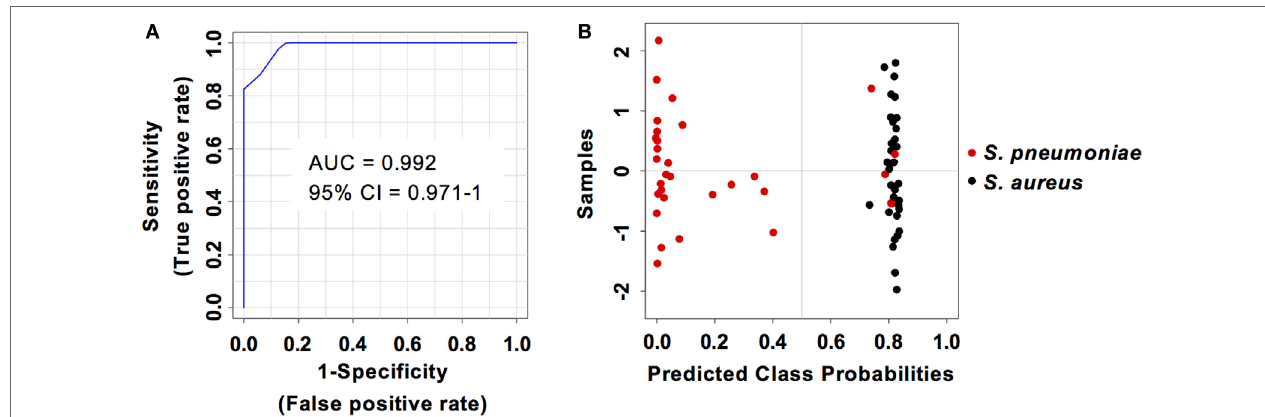
FigUre 7 | Predictive performance of the predictive model built on the set of the two biomarkers CXCL9 and CXCL10. (a) Receiver operating characteristic curve and area under the receiver operating characteristics curve (AUC) value of the predictive model built combining the serum levels of CXCL9 and CXCL10 calculated using Monte Carlo cross-validation. (B) Plot of posterior classification probability showing the segregation of Streptococcus pneumoniae (red symbols) and Staphylococcus aureus (black symbols) infection samples according to the CXCL9/CXCL10 predictive model. Each symbol represents the classification probability that a given infected sample belongs to the S. pneumoniae or to the S. aureus group. The classification boundary is shown by a dotted line at x = 0.5.